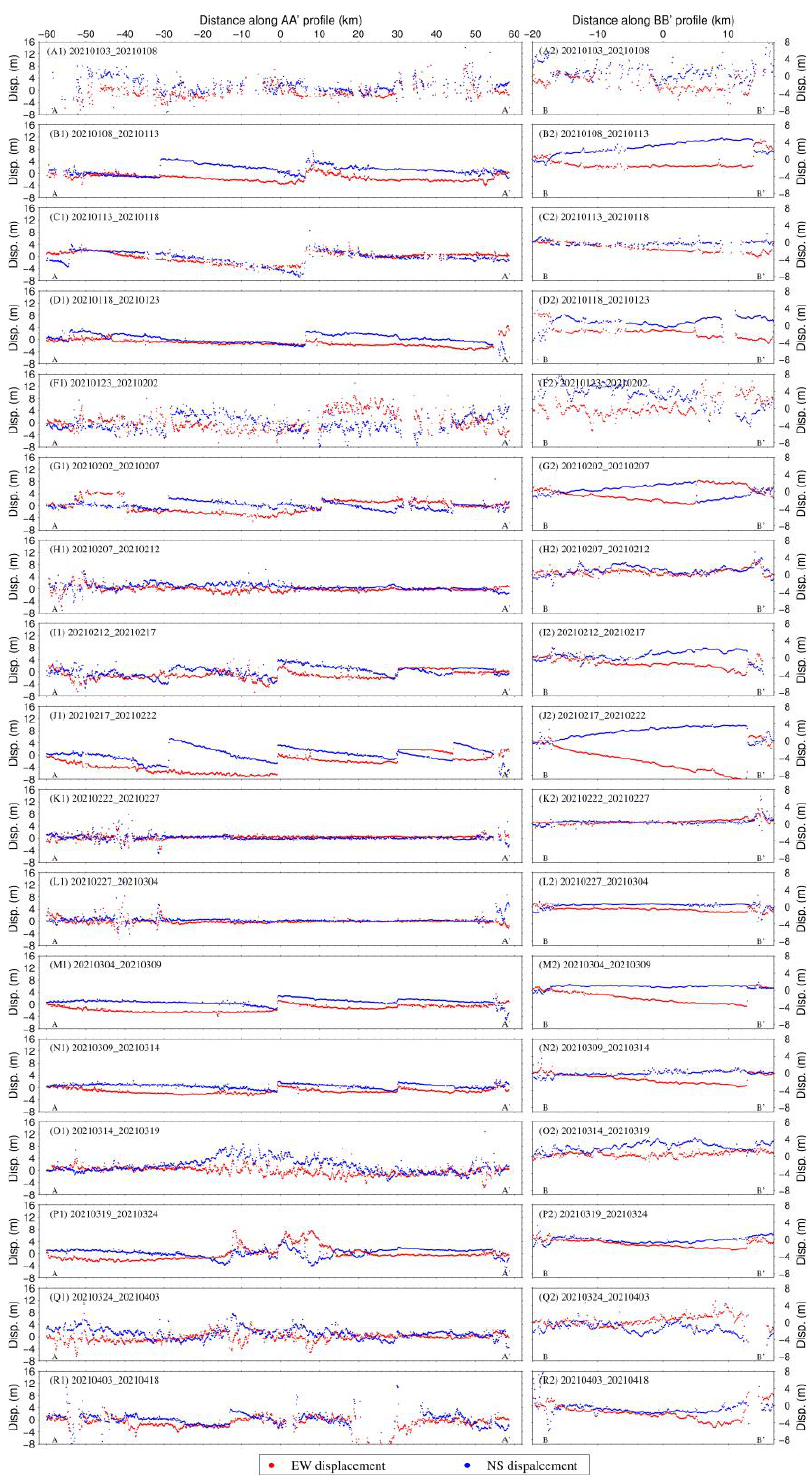
Figure 9. ( A1 – R2 ) represent the displacement values and changing trends on the EW and NS components along the profile AA’ and BB’. The dotted line in Figure 6(A1) indicates the position where the displacement gradient changes on the ice surface. The red dot in the figure represents the EW displacement value, and the blue dot represents the NS displacement